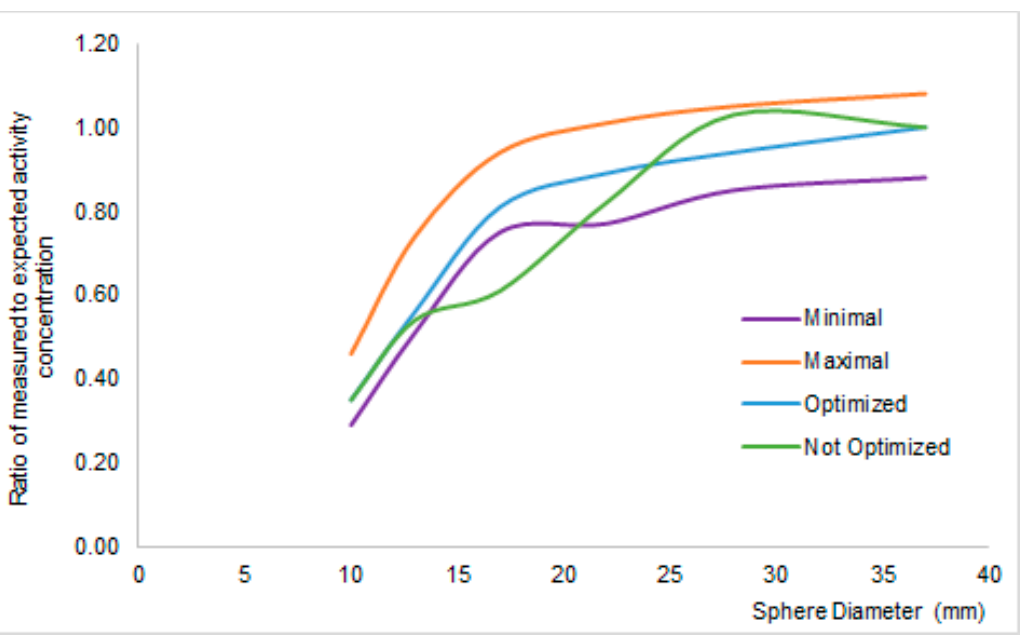
Figure 2. Recovery coefficient curves describing the loss of uptake in the function of a lesion’s size. The blue line is an example in which the reconstruction algorithm has been optimized in respect to the green line. Purple and orange curves are tolerated deviations.